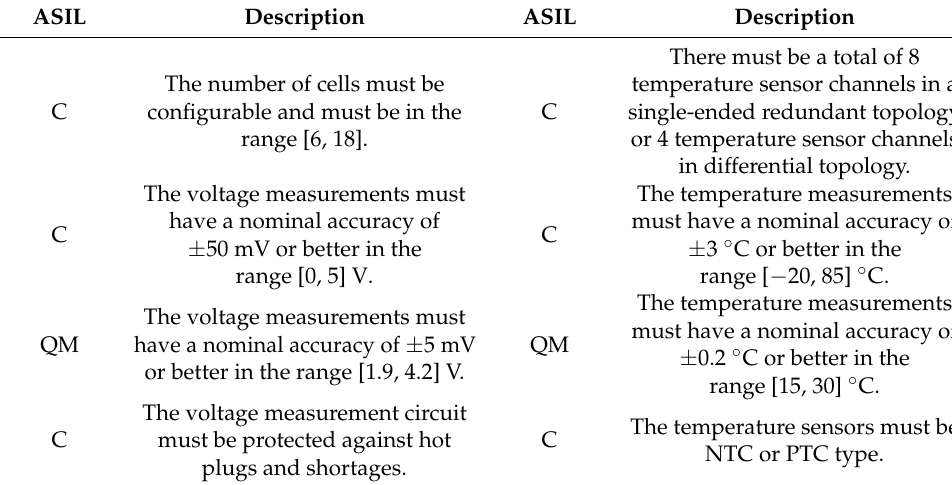
Table 5. Technical safety requirements of the enhanced BMS Slave.